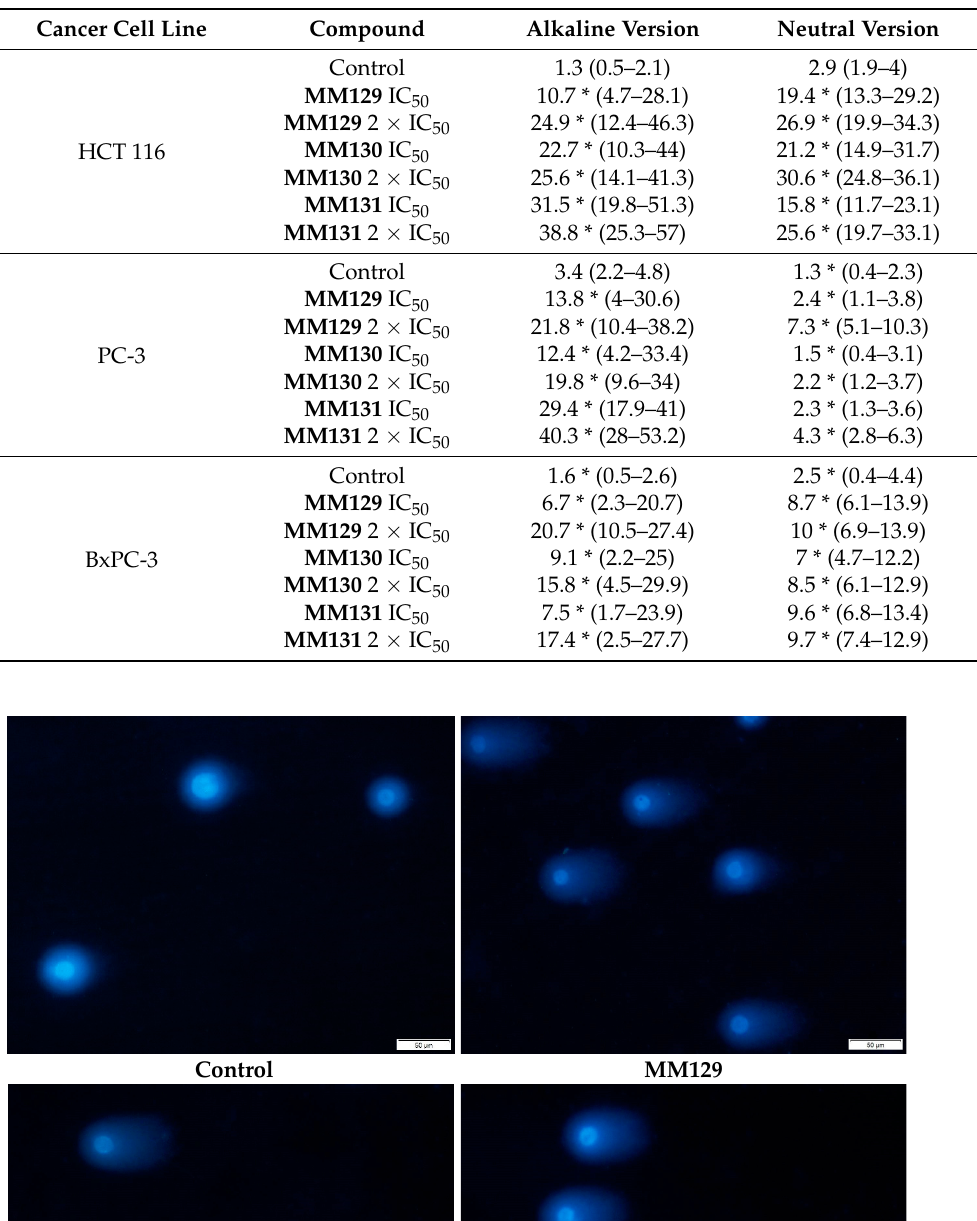
Table 1. Comparison of the results of the alkaline and the neutral comet assay. DNA damage was shown as a median of the percentage of DNA in comet tail with an interquartile range (parentheses). Significant differences ( p < 0.0001) compared with control (*).